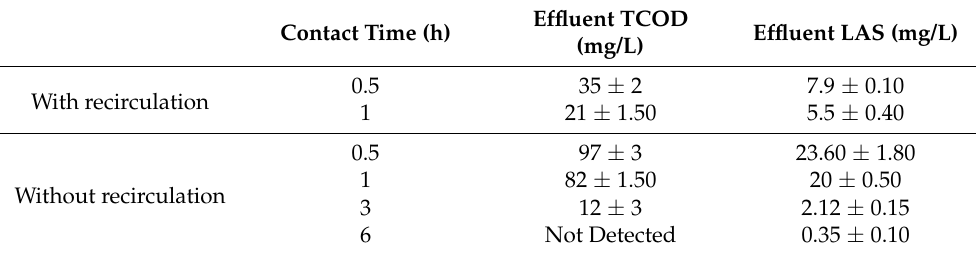
Table 3. Impact of liquid recirculation on effluent characteristics from GAC